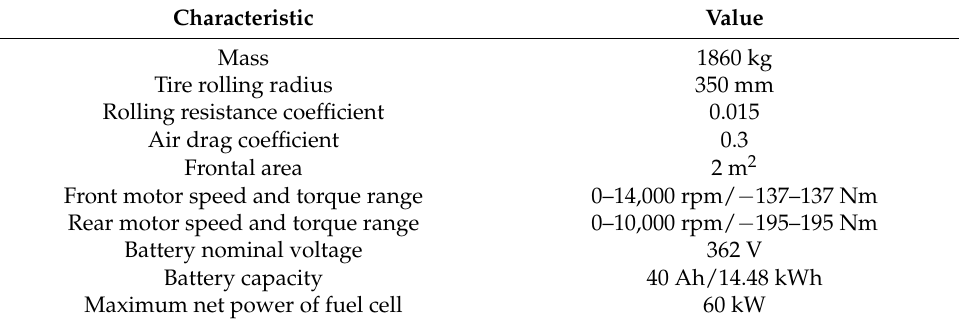
Table 1. Basic parameters of the studied PFCEV.